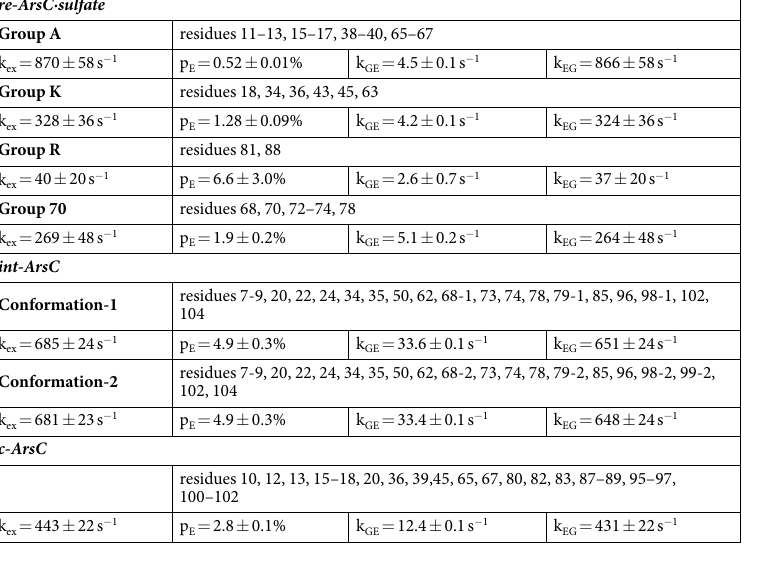
Table 1. Summary of the kinetic parameters of ArsC from CPMG RD